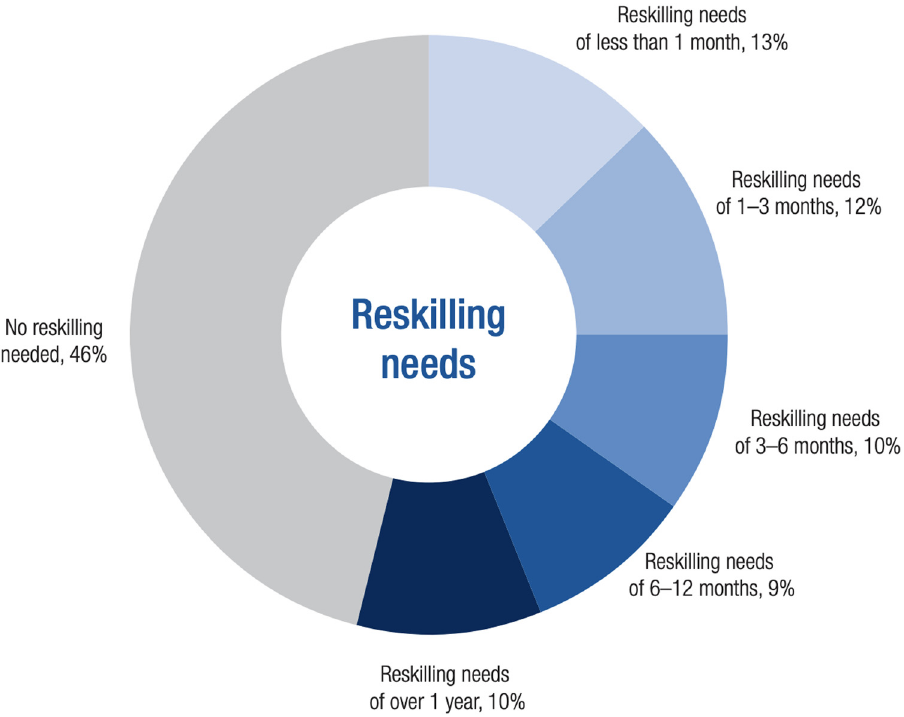
Figure 4: Expected average reskilling needs across companies by share of employees between 2018 and 2022, World Economic Forum, 2018 [ 31 ]